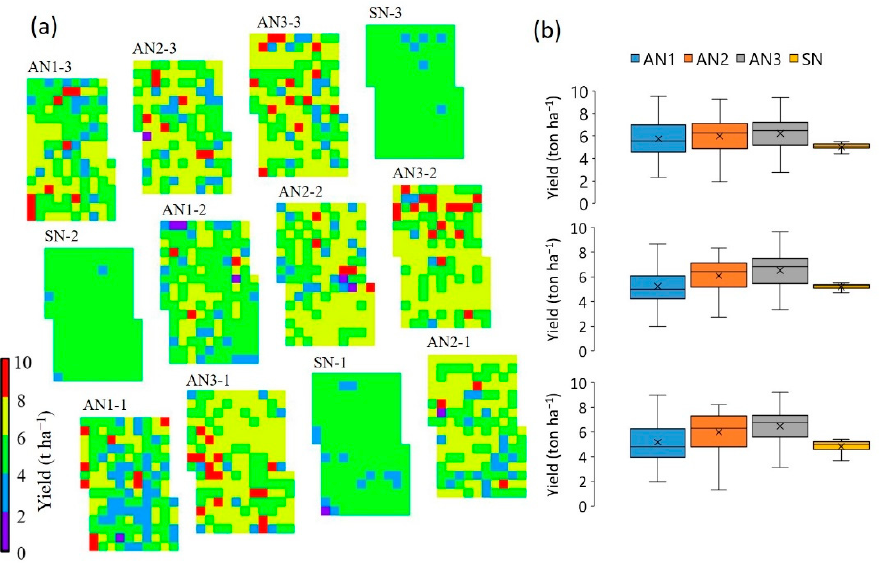
Figure 8. The plots show 2D variations in simulated wheat yield ( a ) and the corresponding box and whisker plots ( b ) at the Gyeongsang National University field in 2021. AN1 = autumn-sown with nitrogen (N) treatments of 40% (40 kg ha − 1 ) at seeding, 30% (30 kg ha − 1 ) at rejuvenation, and 0% (0 kg ha − 1 ) at early reproduction (N40-30-0); AN2 = autumn-sown N40-30-30; AN3 = autumn-sown N40-30-60; SN = spring-sown N40-30-30. The numbers adjacent to the dash symbols represent experimental blocks. Error bars and boxes represent the yield data’s 10th, 25th, 75th, and 90th percentiles, presenting the median (solid line) and mean ( × ).